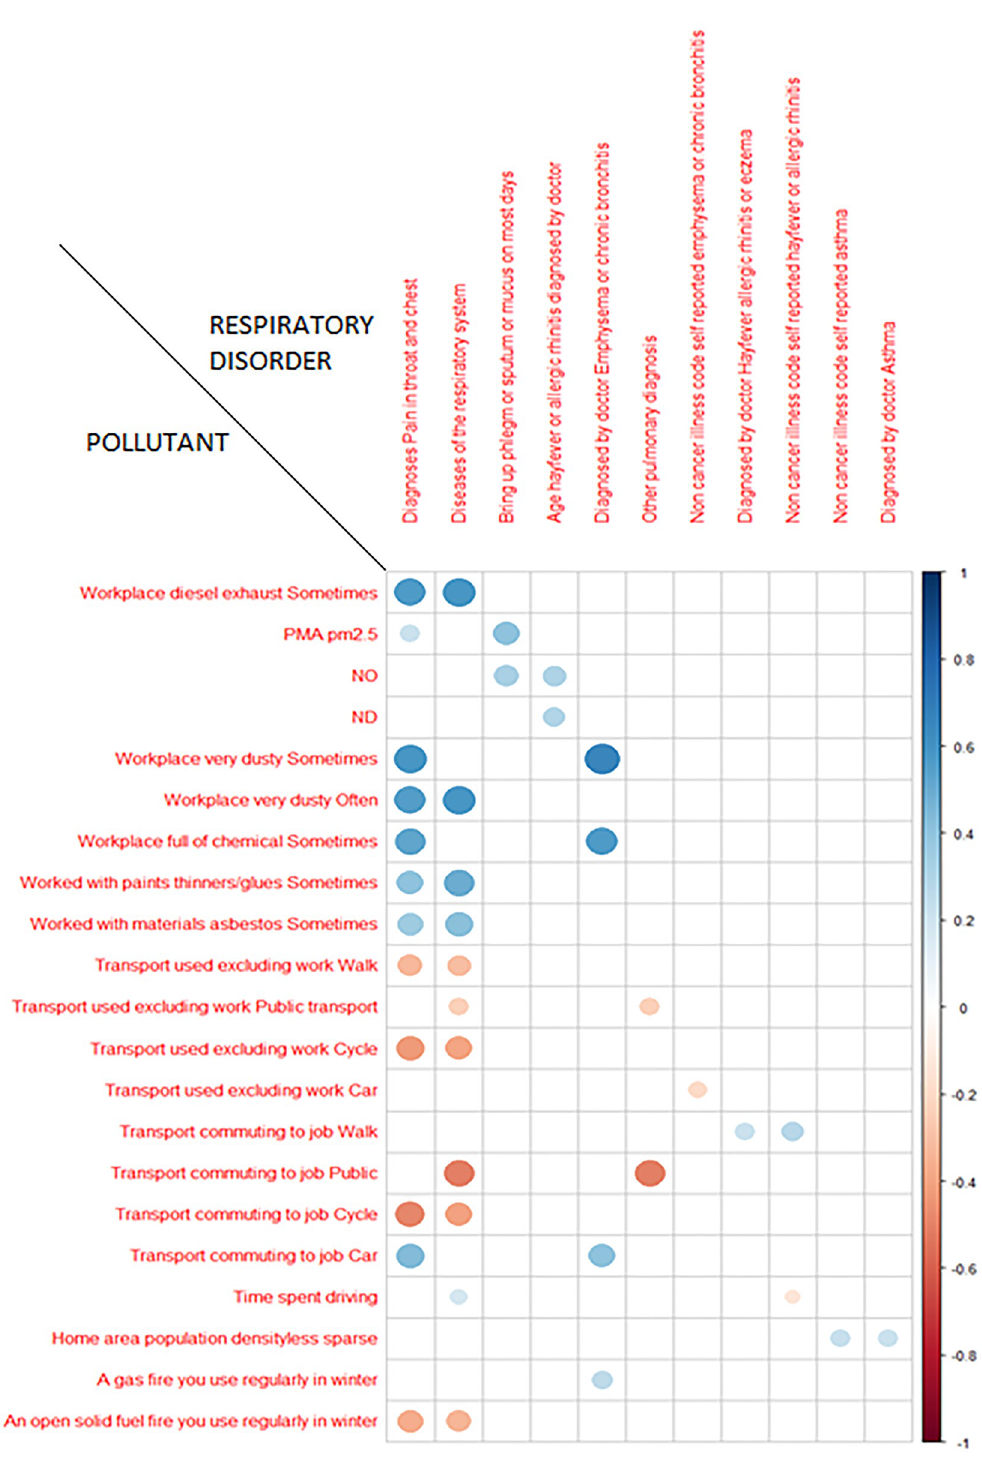
Fig 1. Top genetic correlations. Chart reports the most significant Genetic Correlations for each pollutant. The size and color of the dots represent respectively the genetic correlation measurement. The blue color represents a positive correlation, while the orange color represents a negative correlation. NO: Nitrogen oxides air pollution; 2010. ND: Nitrogen dioxide air pollution; 2010. PMA pm2.5: Particular matter air with diameter less than 2.5 mm.